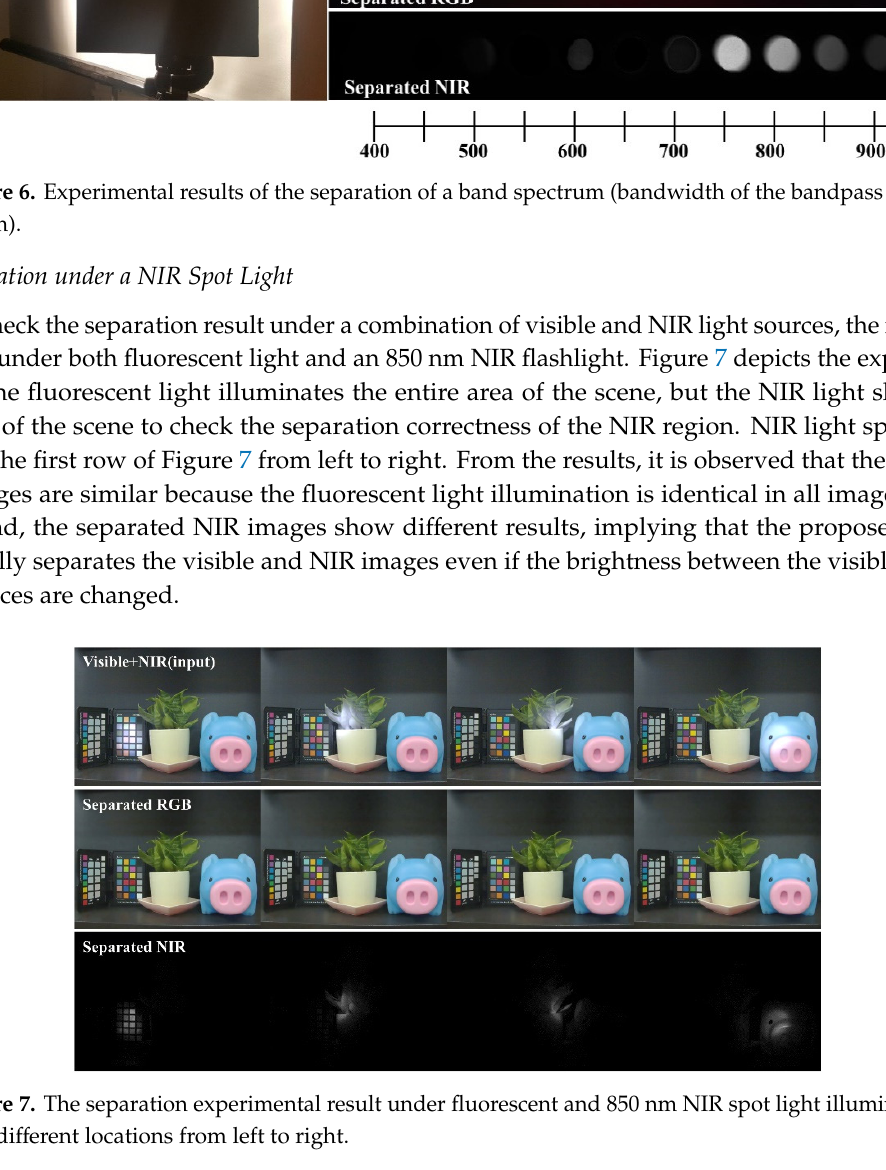
Figure 5. Imaging system used in the experiment. ( a ) The IR cut filter and imaging detector in the camera, ( b ) the camera used in the experiment.